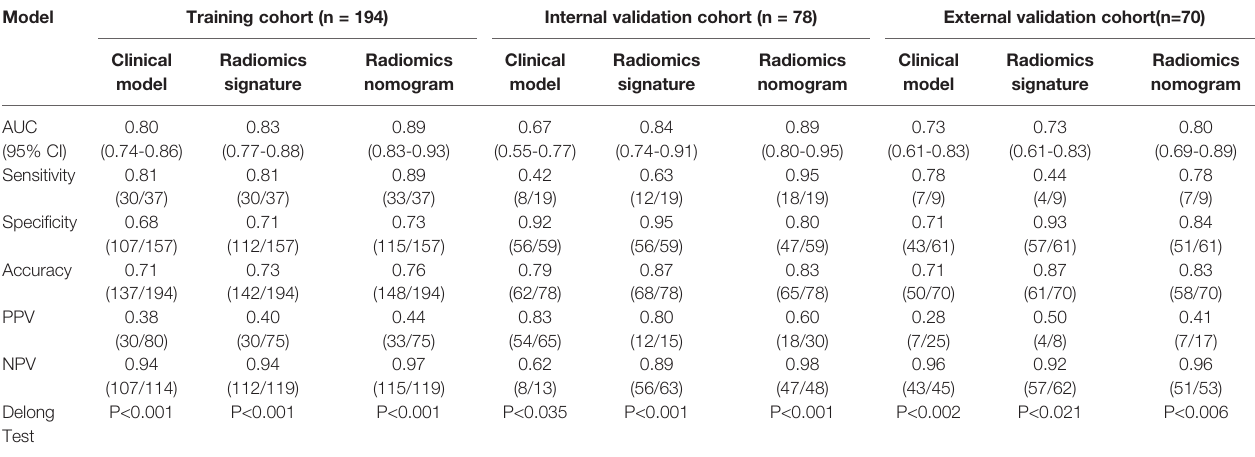
TABLE 5 | Predictive performance of the clinical model, radiomics signature, and radiomics nomogram in the training and validation cohorts. Model